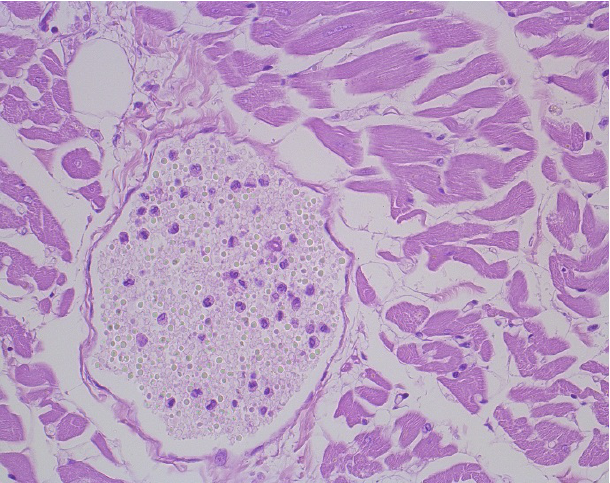
Fig. 3. Heart. The venous vessel is sharply enlarged, filled with shaped elements of blood. McManus. EP. 10, lens. 40 In some cases, in the lumen of the venous vessels throm- botic masses with aggregation and agglutination of red blood cells by type of soot phenomenon were revealed. Plasma impregnation of the walls of blood vessels, swelling of their elastic and argyrophilic fibers were noted. Around the vascular and intermuscular connective tissue stroma due to the destruction of collagen fibers and an increase in the Fig. 1. Heart of the circular shape, coronary vessels di- content of glycoproteins, loosening and accumulation in lated, overfilled with blood